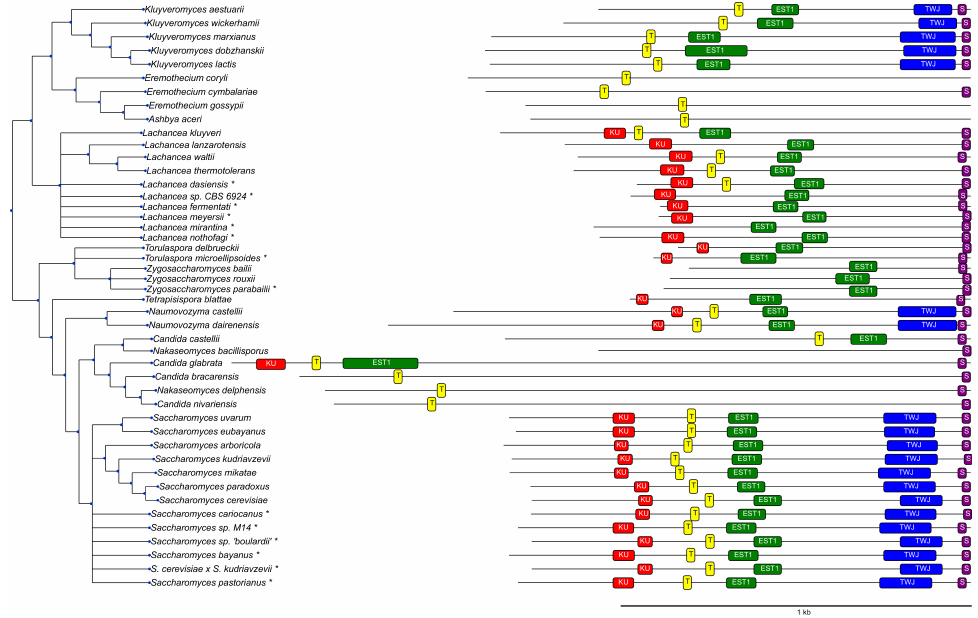
Figure 2. Features identified in TER sequences. ( KU ) ku binding hairpin, ( T ) template region, ( EST1 ) Est1 binding site, ( TWJ ) three-way junction, and ( SM1 ) SM1 binding site. Elements not shown are either not present in the corresponding species (e.g., the TWJ in Candida glabrata ) or could not be located with reasonable certainty. Species marked by * are not part of the phylogenetic tree and were placed next to their closest related neighbor based on the similarity of their TER